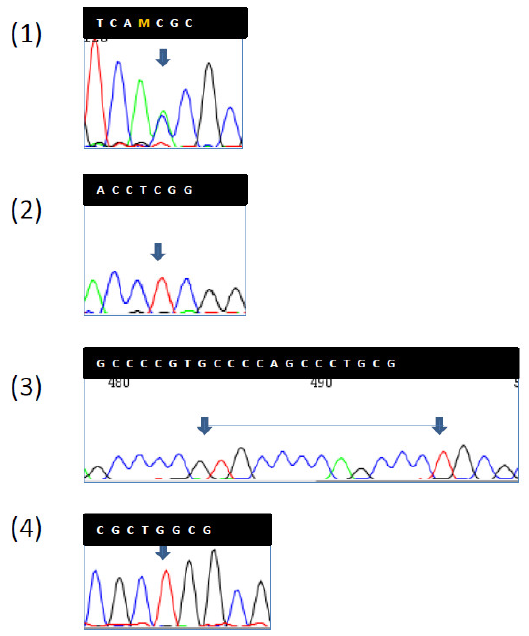
Figure 3. Four germline mutations, one of uncertain significance and three presumably benign were found in the CDH1 gene. Sequence chromatograms. ( 1 ) mutation of uncertain significance located in the promoter region of the E-cadherin CDH1 gene (rs16260 C/A); ( 2 ) mutation located in the intron 1 (rs3743674 T/T); ( 3 ) insertion located in the intron 1 (rs74406246 ins); ( 4 ) mutation located in the codon 13 (rs2076 T/T).